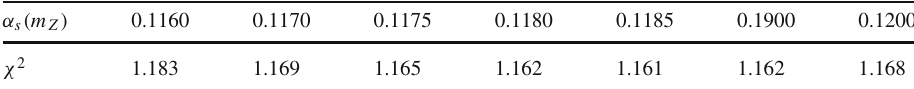
Table 23 Values of the total χ 2 per data point for the NNLO global fit with different values of α ( m s Z